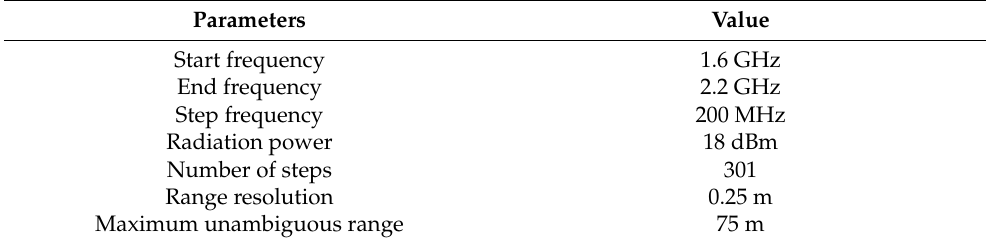
Figure 9. Photographs of the experimental environment. ( a ) Single target scenario. ( b ) Double target scenario. Table 2. The key parameters of UWB